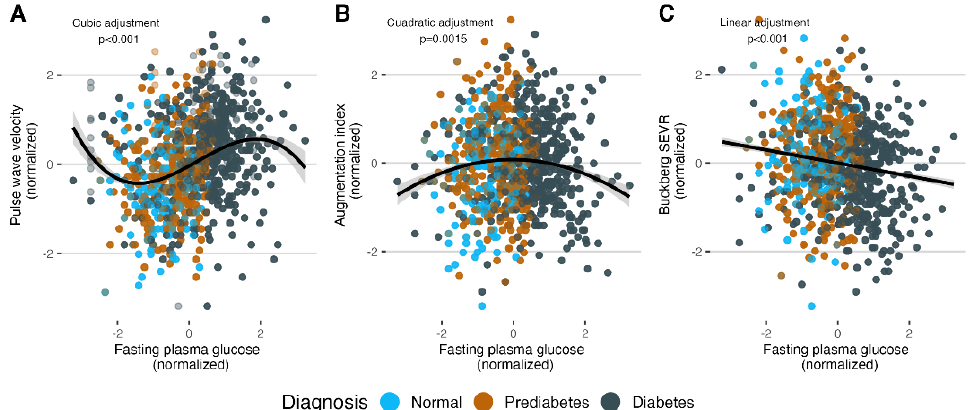
Figure A3. Relationship between fasting plasma glucose and different vascular health parameters; PWV ( A ), AIX75 ( B ), and Buckberg SEVR ( C ). The best polynomic adjustment was assessed with